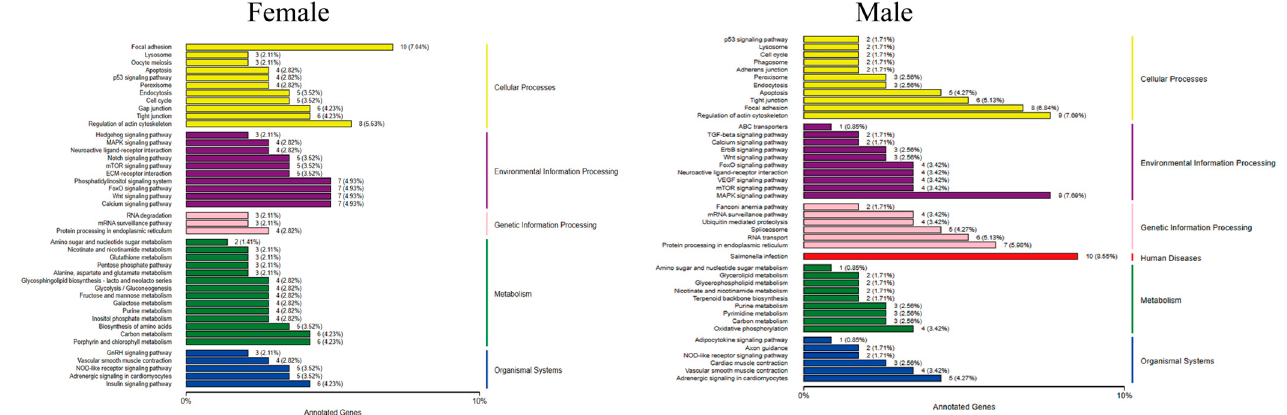
Figure 7. Classification of the differentially expressed gene KEGG in G. rarus after 14 days of exposure to 100 ng/L MT.